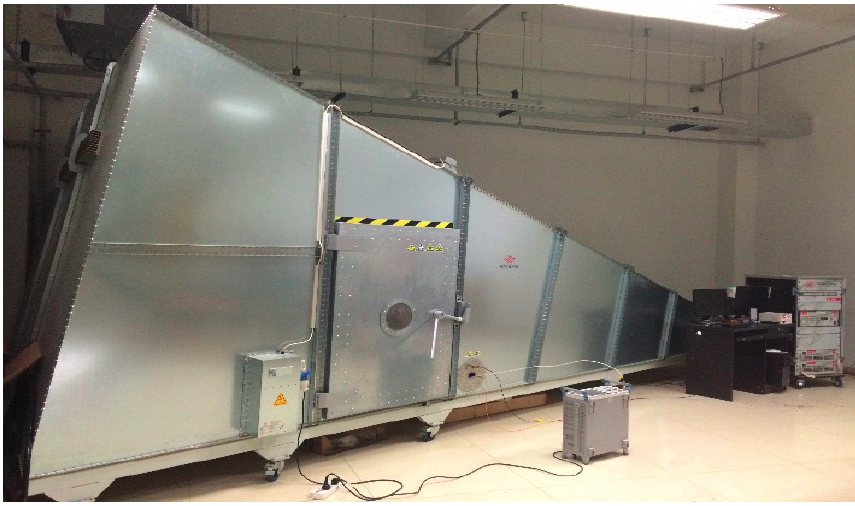
Figure 11. Experimental setup for calibration of AFs.